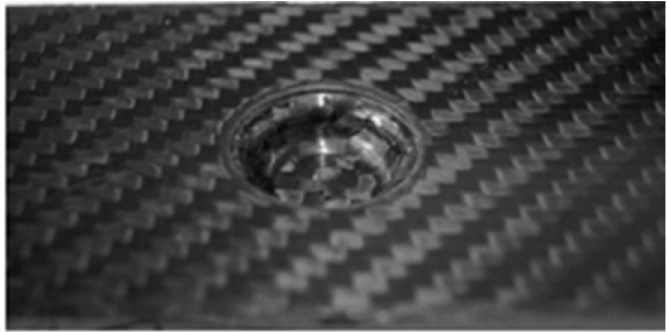
Figure 5. Corrugation formed into a thermoset matrix woven composite laminate [24].